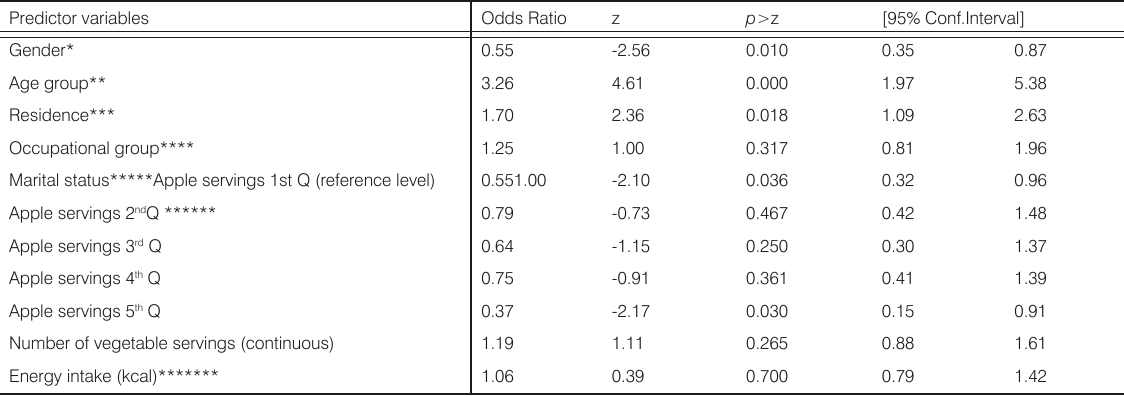
Table 5. Risk of colorectal cancer (ORs) related to consumption of apple servings (in quintiles) estimated from the multivariate logistic model adjusted to potential confounding factors.